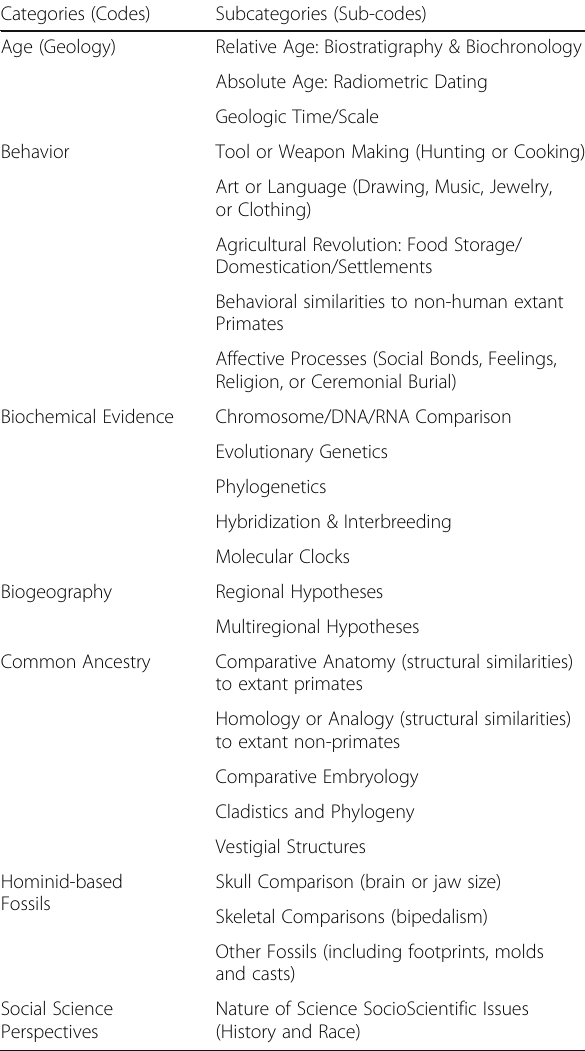
Table 1 Seven types of evidence (categories, codes) and examples (subcategories, sub-codes) in teaching for